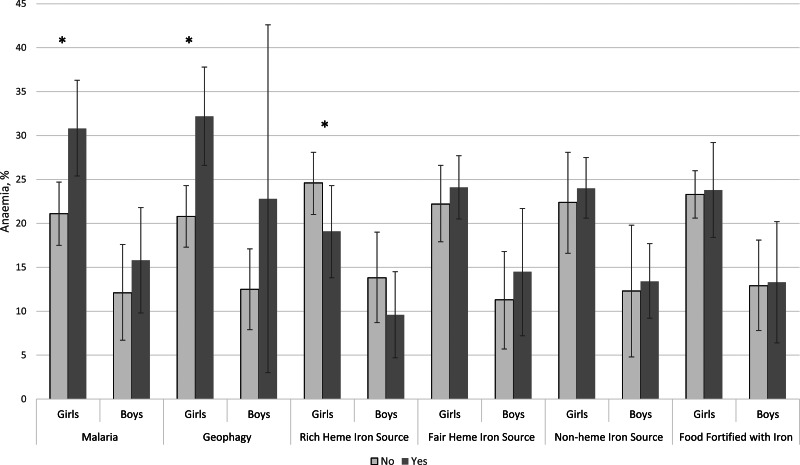
Unadjusted prevalence of anaemia among adolescent girls and boys in Ghanaian Schools by malaria, geophagy and selected dietary variables, Northern, Upper West, Volta, Western and Western North regions (n 2948). Note: *P < 0⋅05. Values are weighted. Complex survey procedures used to account for clustering. Data for boys only available for Upper West, Western and Western North regions. Rich sources of haeme iron included red meats and organ meats; fair sources of haeme iron included white meats/poultry, eggs and fish; sources of non-haeme iron included dark green leafy vegetables, legumes and seeds; fortified foods included cereals such as Nestle Cerelac and beverages such as Nido and Milo; anaemia was defined using age-/sex-specific haemoglobin concentration cut-off values (children 10–11 years: Hb < 11⋅5 g/dl; girls ≥ 12 years and boys 12–14 years: Hb < 12⋅0 g/dl; boys ≥ 15 years: Hb < 13⋅0 g/dl).